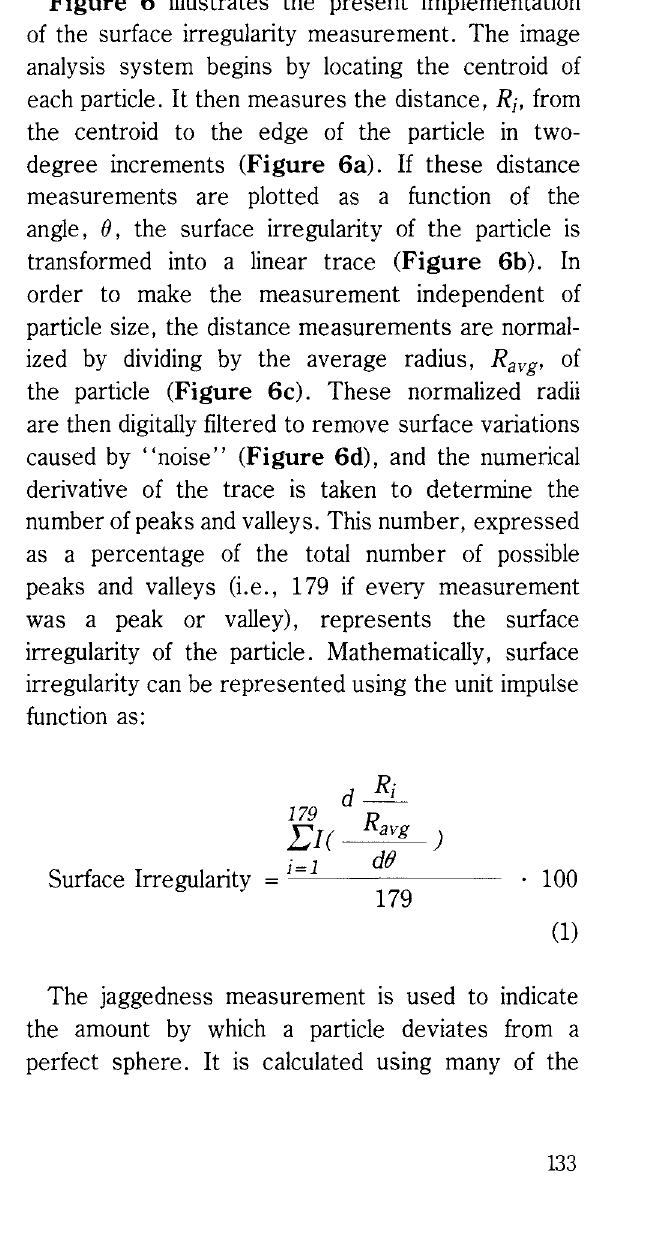
Fig. 4 Comparison of elongation ratios obtained using image analysis and manual measurement techniques.